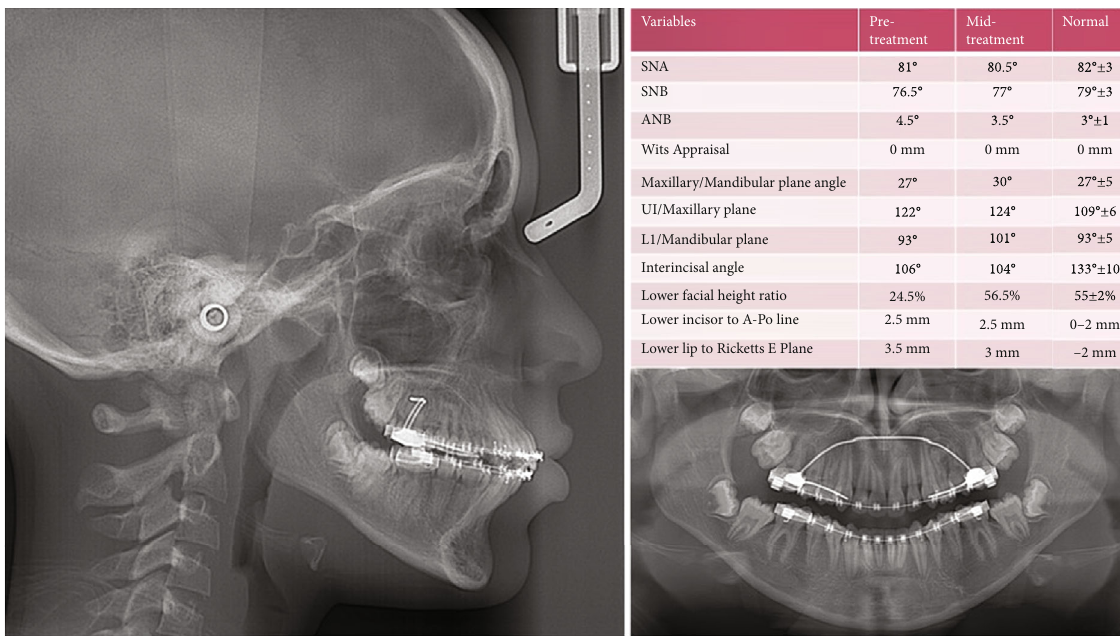
Figure 6: Midtreatment radiographs and